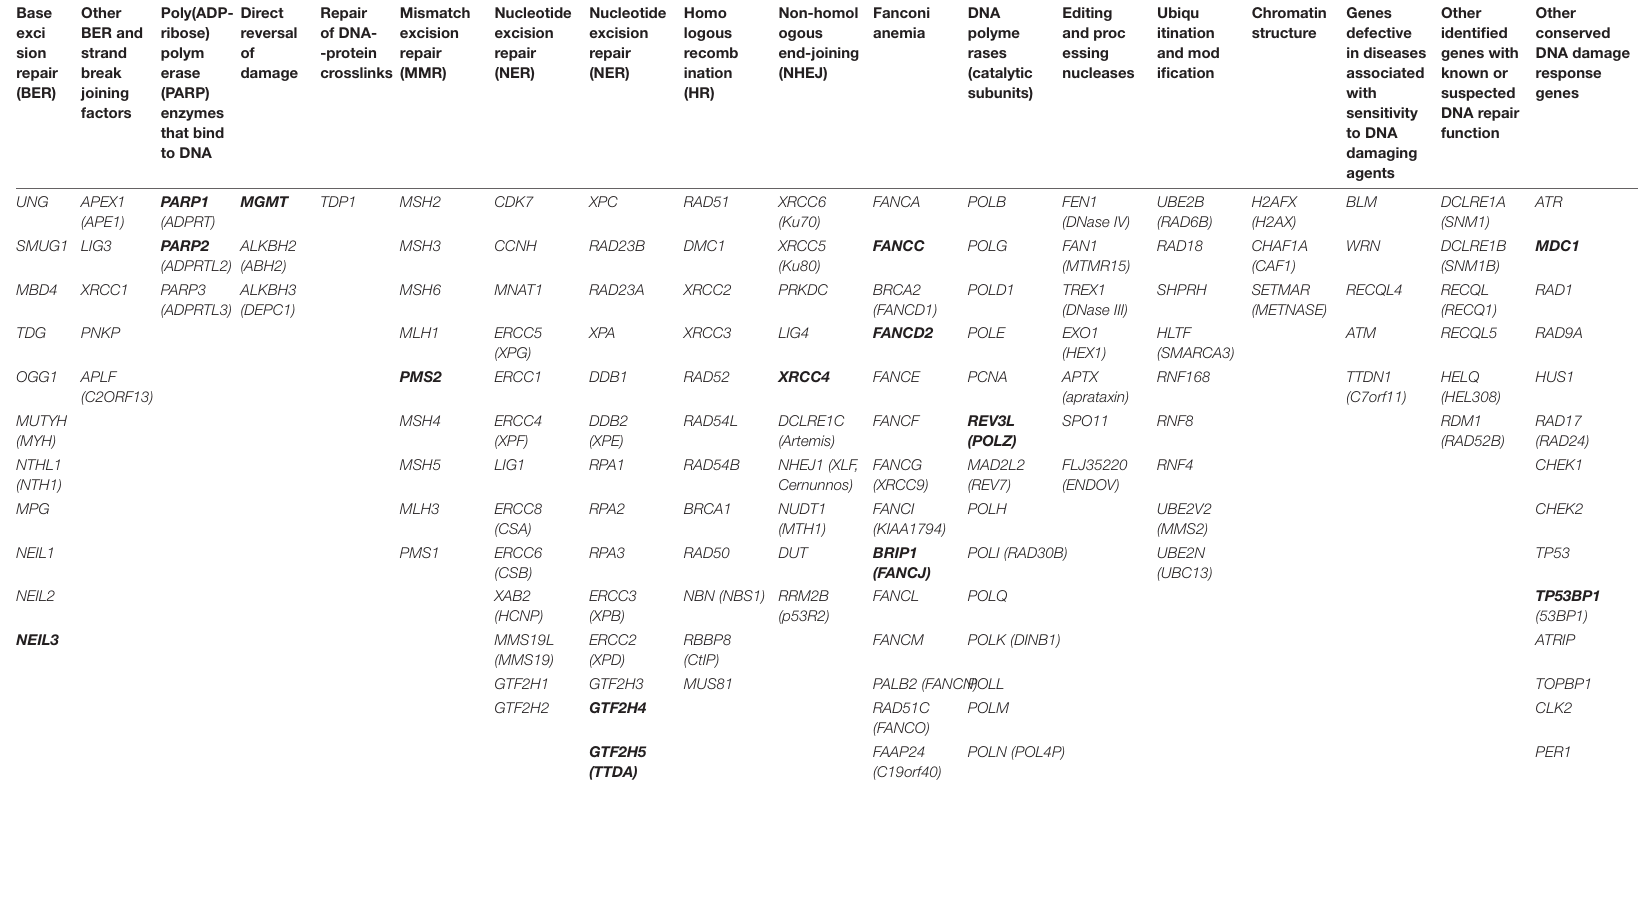
TABLE 2 | Total 153 studied genes grouped based on DNA repair type (genes where the SNPs were associated with CAs are in bold